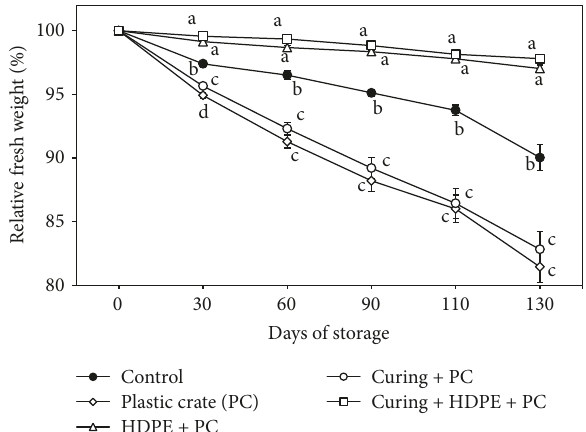
Figure 3: Changes in relative freshweight (%)of radish rootsduring storage at low temperature under different packaging treatments. Vertical bars represent ± SE of mean. For each evaluation day, different letters indicate significant differences ( 𝑃 < 0.05 ) among